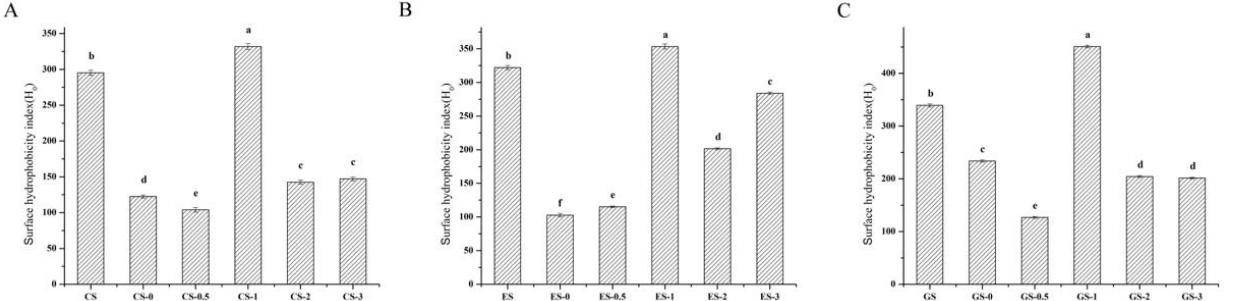
Figure 3. Endogenous fluorescence spectrum of fish gelatin. ( A ) CS, CS-0, CS-0.5, CS-1, CS-2, CS-3: CS gelatin, CS gelatin phosphorylated by STMP for 0, 0.5, 1, 2 and 3 h, respectively. ( B ) ES, ES-0, ES-0.5, ES-1, ES-2, ES-3: ES gelatin, ES scale gelatin phosphorylated by STMP for 0, 0.5, 1, 2 and 3 h, respectively. ( C ) GS, GS-0, GS-0.5, GS-1, GS-2, GS-3: GS gelatin, GS gelatin phosphorylated by STMP for 0, 0.5, 1, 2 and 3 h, respectively.